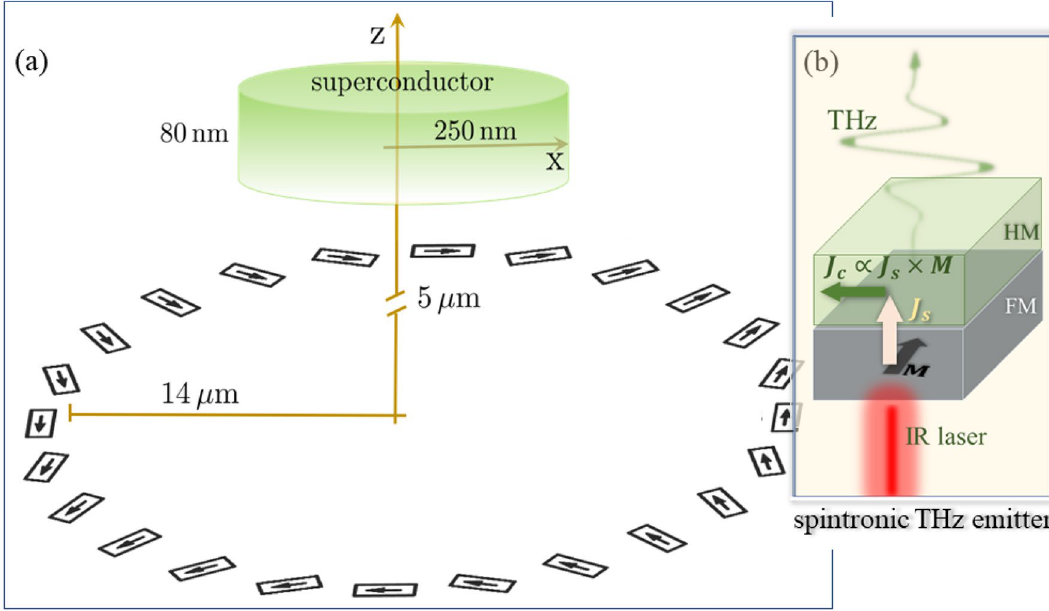
Figure 1. Setup of the considered system (not to scale). ( a ) A type II superconducting disc of 80 nm height 28 µ m size metastructure of spintronic terahertz and 250 nm radius is placed 5 µ m above the center of ≈ emitters (STEs). ( b ) An enlarged view of the key elements of one STE consisting of a ferromagnetic (FM) layer with magnetization M , interfaced with a heavy metal (HM) that acts as a strong spin orbit scatterer. A spin polarized current density J s diffuses into the HM upon irradiation of the STE with an IR pulse. The inverse spin J s M results in THz emission. The arrows on each of the STEs in the Hall charge current density pulse J c ∝ × metastructure indicate the local magnetization M ( r ) . J c ( r ) is basically homogeneous in each one of the STEs and points perpendicular to M ( r ) and parallel to the plane of the FM